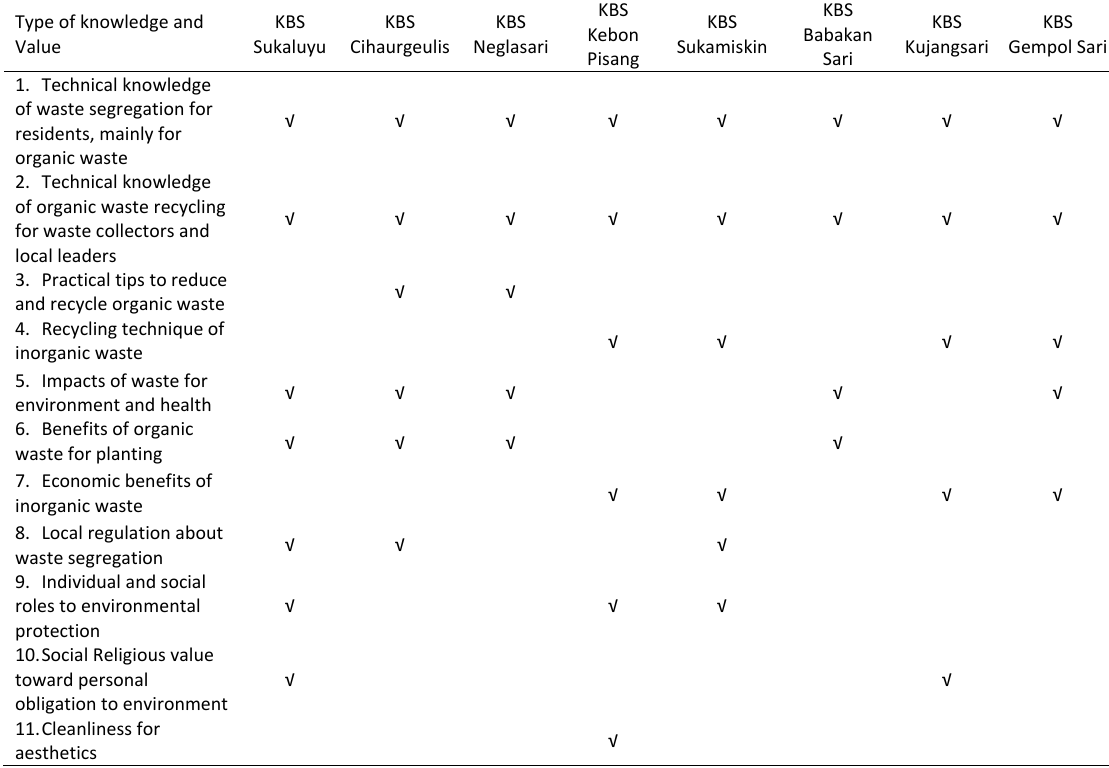
Table 4: The educational contents in the KBS